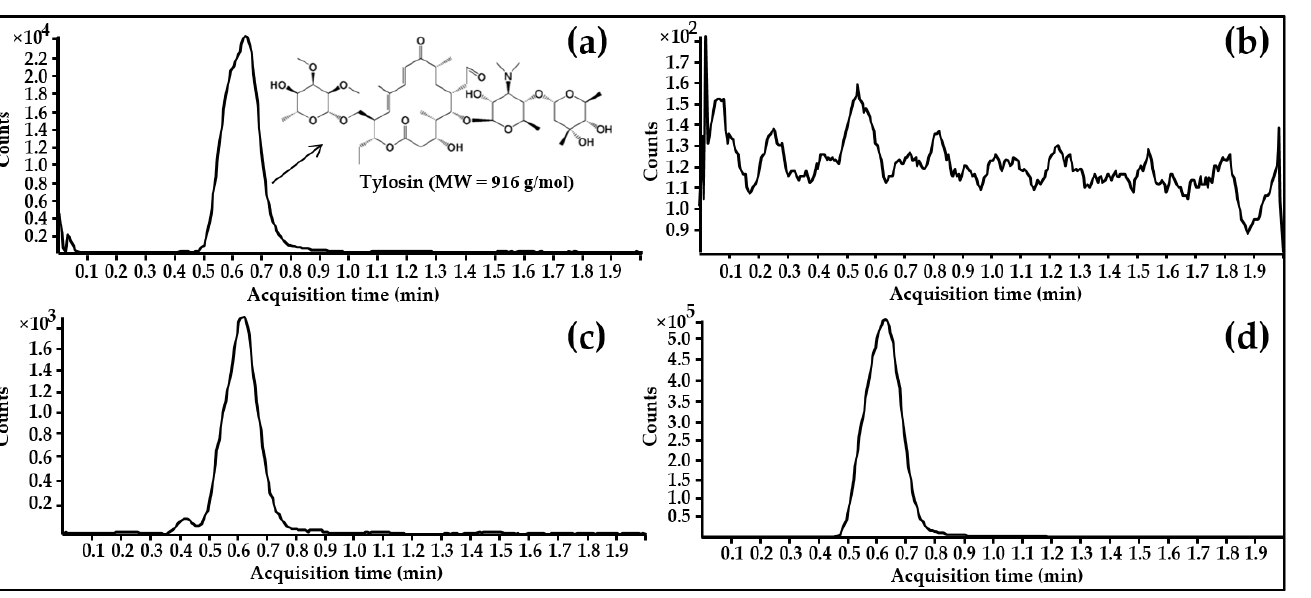
Figure 1. Total ion chromatograms: ( a ) standard solution at 50 ng/mL; ( b ) blank serum sample; ( c ) blank serum sample spiked with tylosin at 10 ng/mL; ( d ) serum sample at 1 h after intramuscular administration of tylosin tartrate. Table 1. Validation parameter for the determination of tylosin in olive flounder serum and muscle concentration analysis using HPLC-MS/MS.